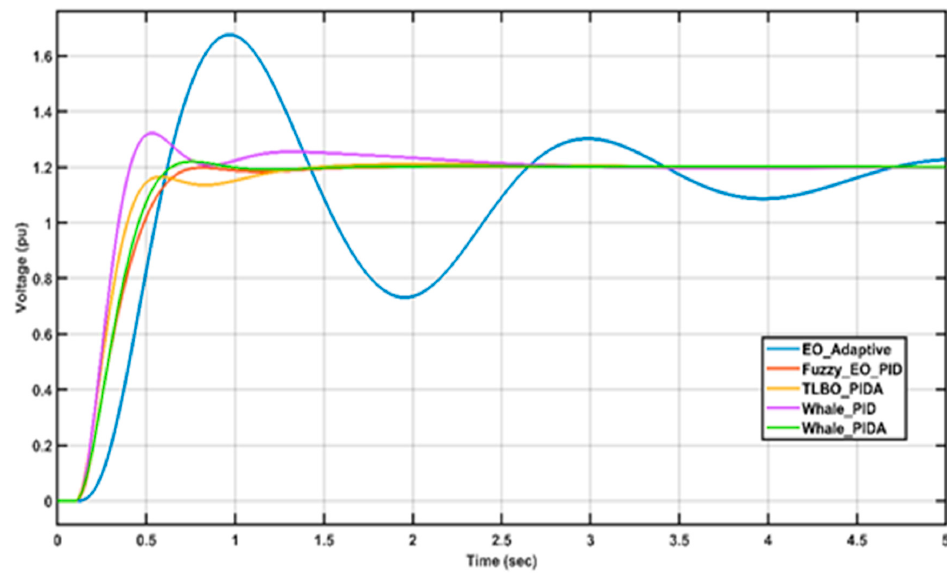
Figure 12. 1.2 pu step voltage reference for simple AVR model.